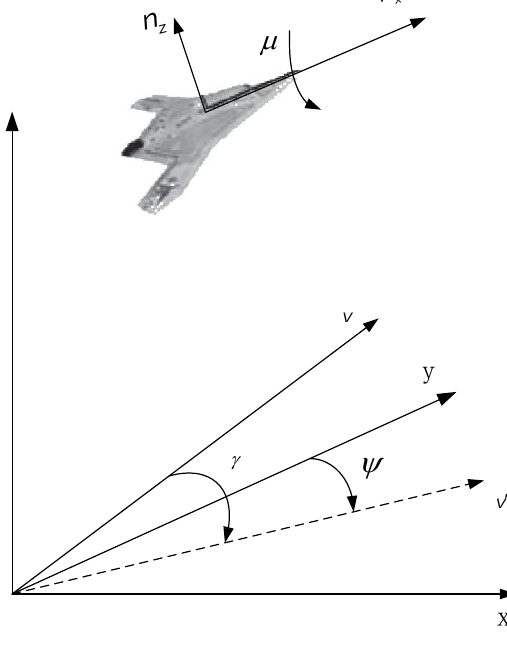
Figure 3. Ground coordinate system for UAV.